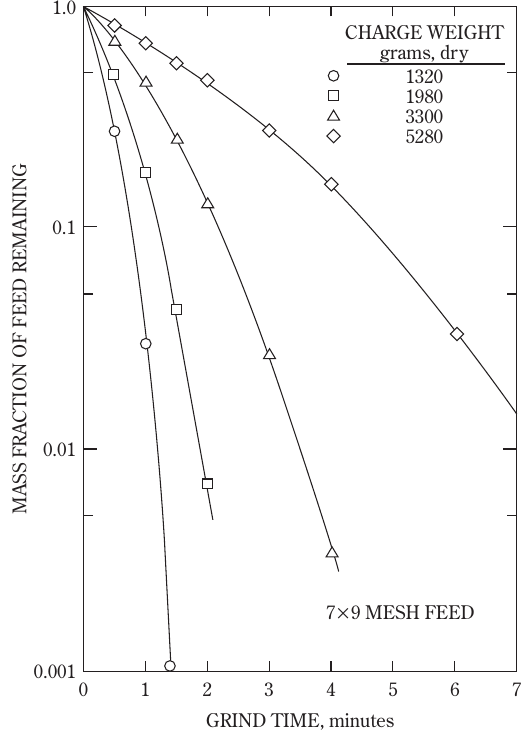
Fig. 3 First order feed disappearance plot for rod mill grinding at several different feed loads in the batch mill.